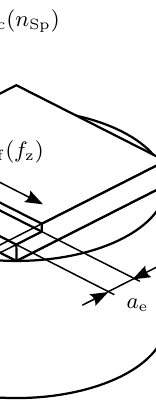
Figure 3. Applied specimen geometry and process kinematics for experimental investigations according to [23].